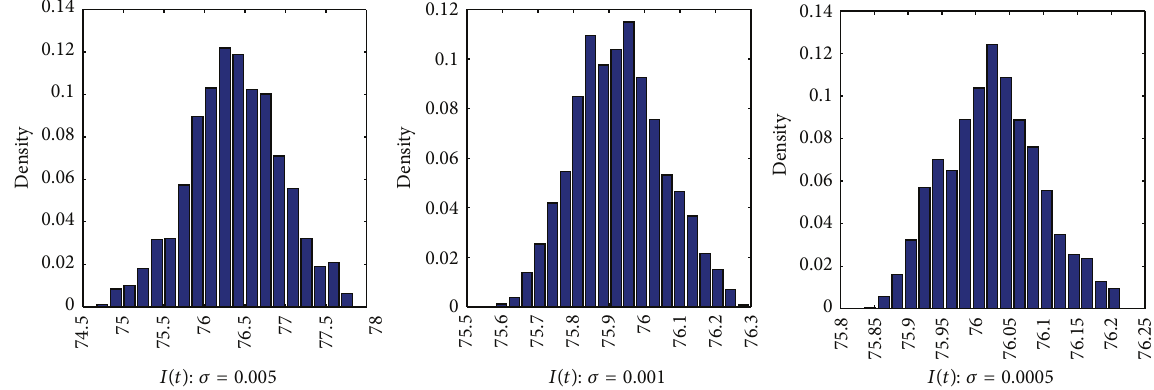
Figure 4: Histograms of the solution 𝐼(𝑡) for model (5) for 𝐼(0) = 10 and differing values of 𝜎 = 0.005 , 𝜎 = 0.001 , and 𝜎 = 0.0005 .